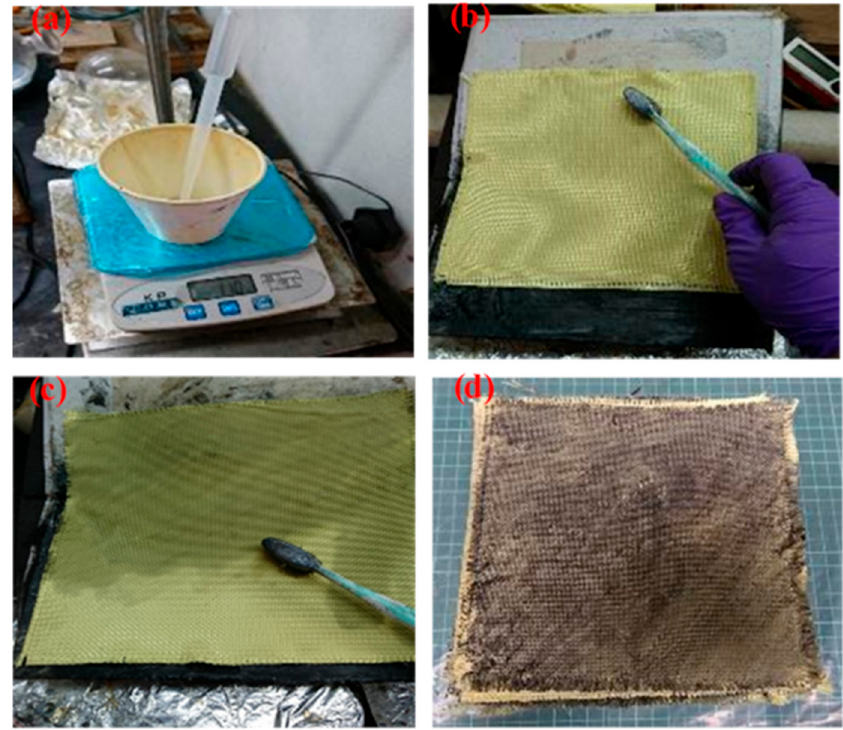
Figure 2. Preparation of polyurea elastomers/Kevlar plates (a) Preparation of polyurea elastomers (b) lay the cut Kevlar fabric flat on the carrier (c) painting polyurea elastomers (d) polyurea elasto- mers/Kevlar plates schematic diagram.